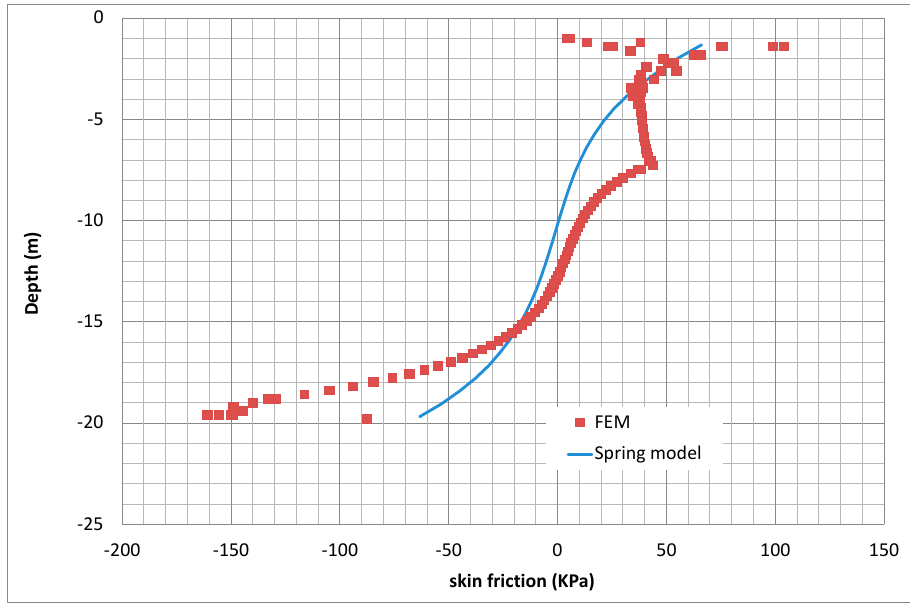
Figure 11. Pile and soil skin-friction comparison.